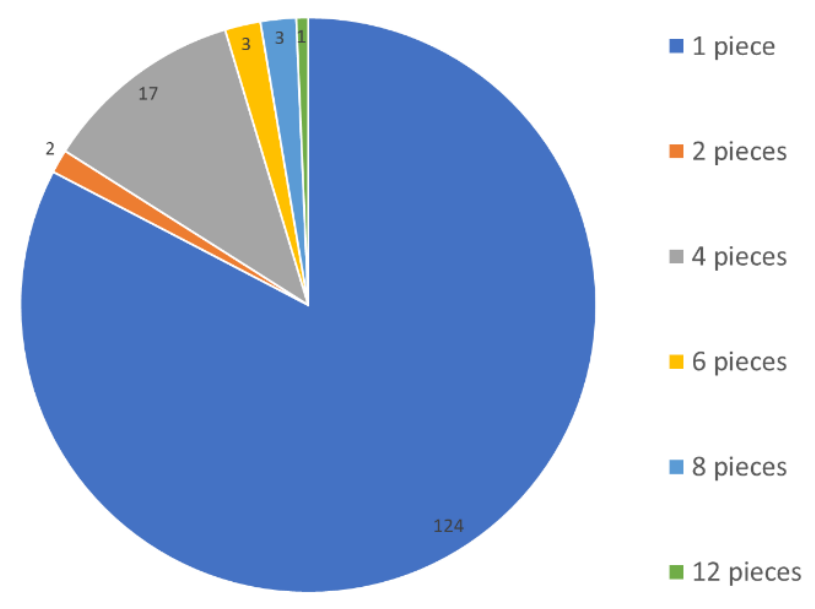
Figure 4. Amount of single packagings (1) and single packagings in bundles of 2, 4, 6, 8 and 12 smaller units; numbers: number of samples, n = 150 .